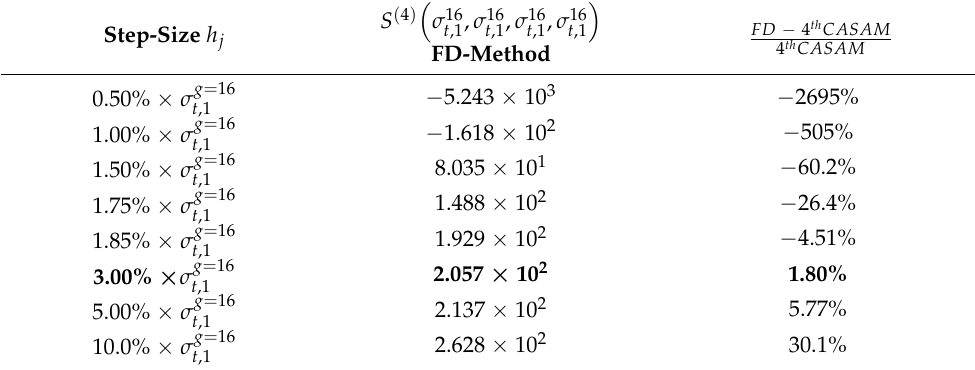
(cid:16) (cid:17) σ 16 , σ 16 , σ 16 , σ 16 using Equation (9) with various t ,1 t ,1 t ,1 t ,1